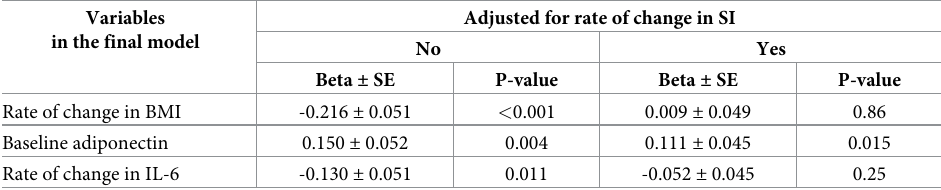
Table 4. Significant multivariate associations with rate of change in DI a . Variables in the final